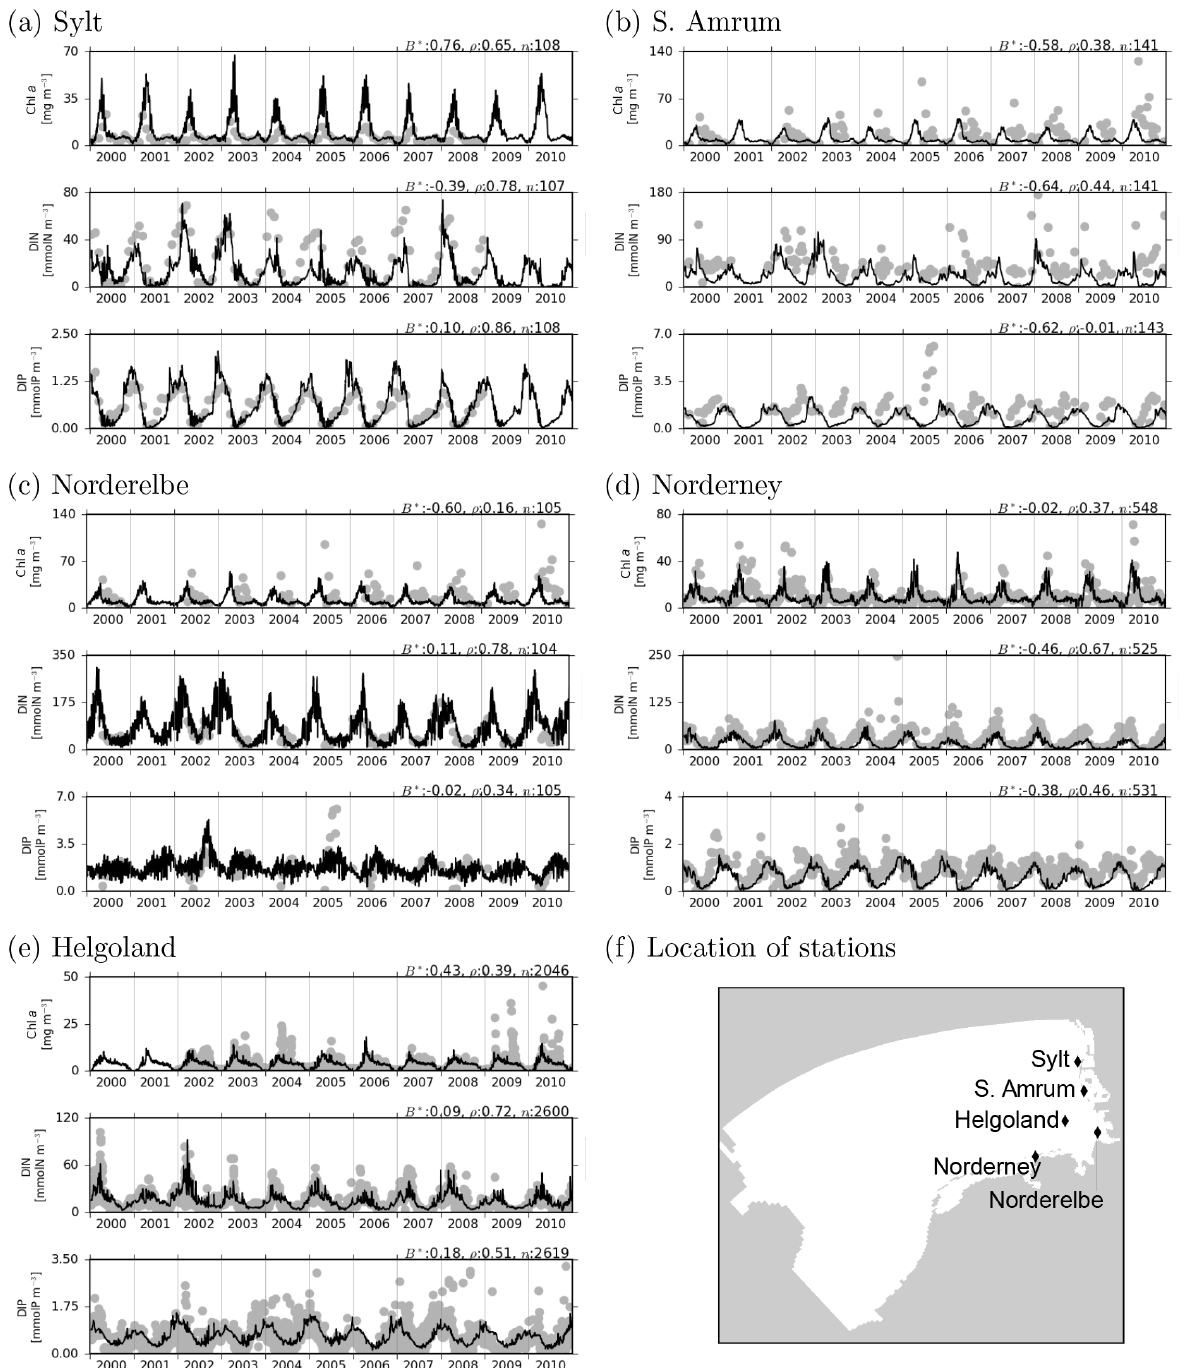
Figure 5. Observations (gray dots) and model estimates (lines) of surface chlorophyll, DIN and DIP concentrations at the stations located along the coasts of the German Bight, operated by the Alfred Wegener Institute (Helgoland and Sylt), Landesamt für Landwirtschaft, Umwelt und ländliche Räume des Landes Schleswig-Holstein (S. Amrum, Norderelbe), and Niedersächsischer Landesbetrieb für Wasserwirtschaft, Küsten- und Naturschutz (Norderney). The normalized bias ( B ∗ ), Pearson correlation coefficients ( ρ ) and corresponding number of data points ( n ) are shown on top of each